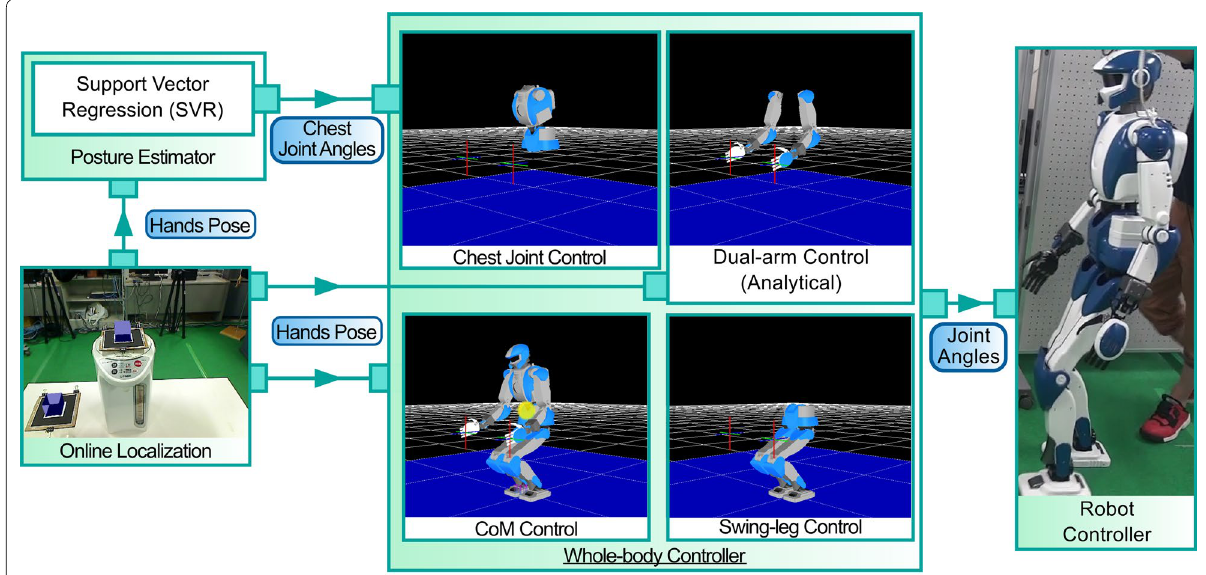
Fig. 5 System overview. Arrows indicate the data flow. The system is formed by the online localization, the posture estimator, the whole-body controller, and the robot controller